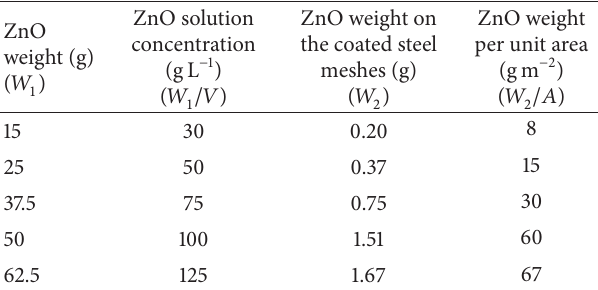
Table 1: The ZnO-coated weight on the steel